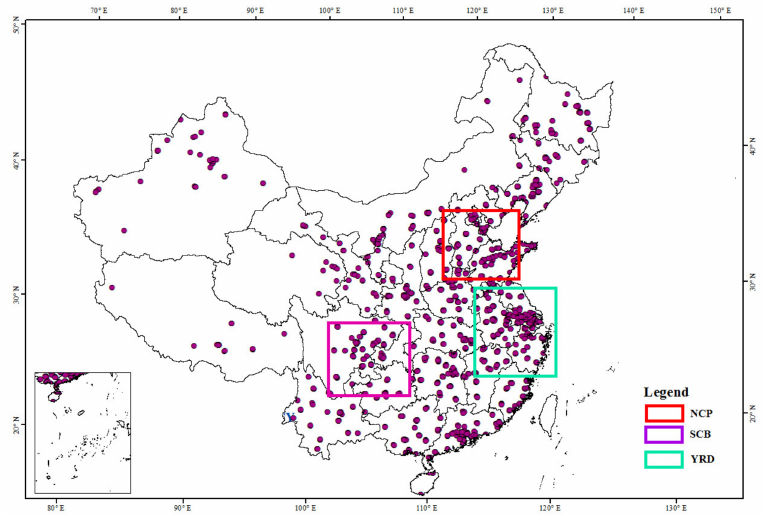
Figure 3. Spatial distributions of surface ozone monitoring stations in China and three typical areas, including the Sichuan Basin (SCB), North China Plain (NCP), and Yangtze River Delta region